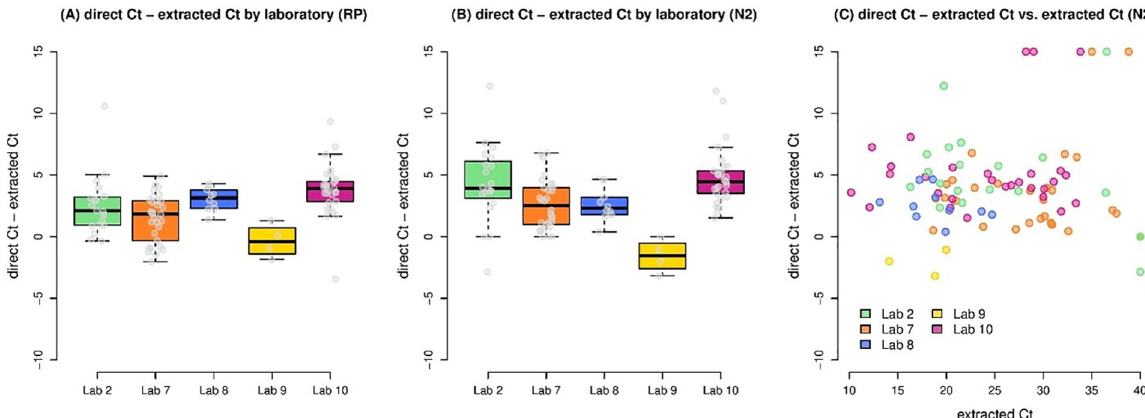
Fig 6. Comparison of direct versus extracted PCR analyses for locally sourced clinical samples (Project C). The left (A) and center (B) boxplots illustrate the difference between direct and extracted Ct values in the five laboratories participating in Project C for the RP and N2 genes respectively. The right boxplot (C) illustrates the difference between direct and extracted Ct values plotted against the extracted Ct value, in five laboratories.